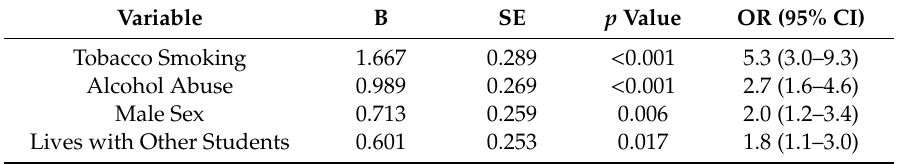
Table 4. Logistic multivariate analysis to identify multifactorial predictors for drug